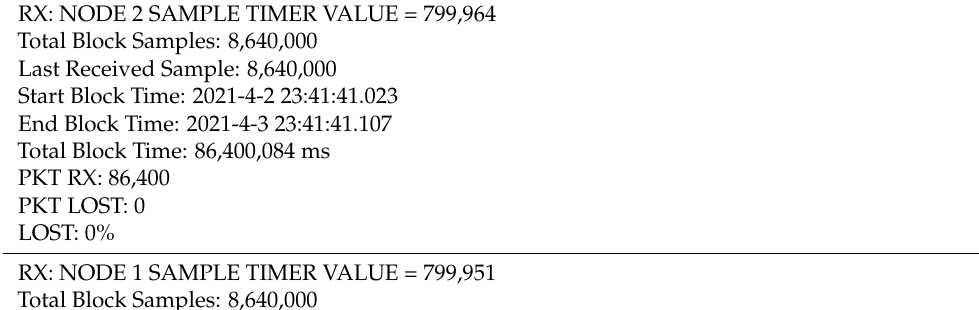
Table 6. Results of 12 h with Sinchro.